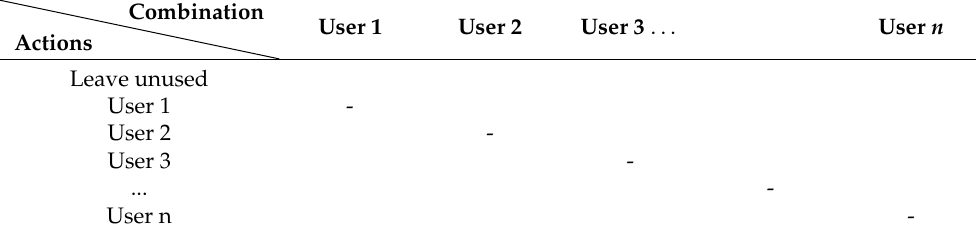
Table 1. Q matrix example of a base station in a cell